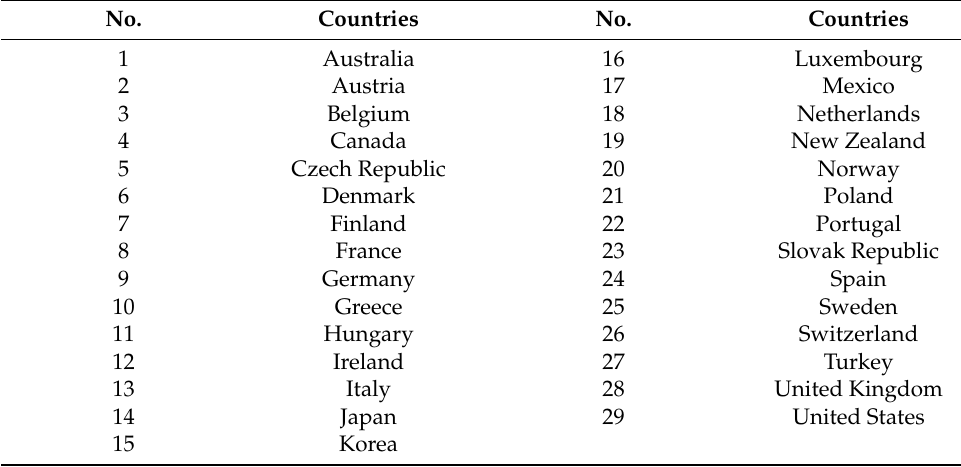
Table A1. List of developed OECD countries under